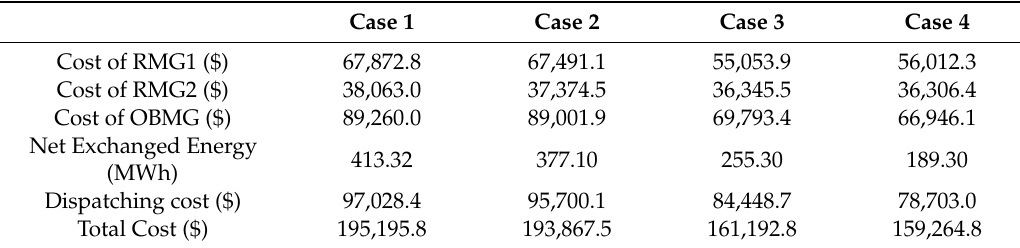
Table 2. Comparison of Costs and Net Exchanged Energy in all Four